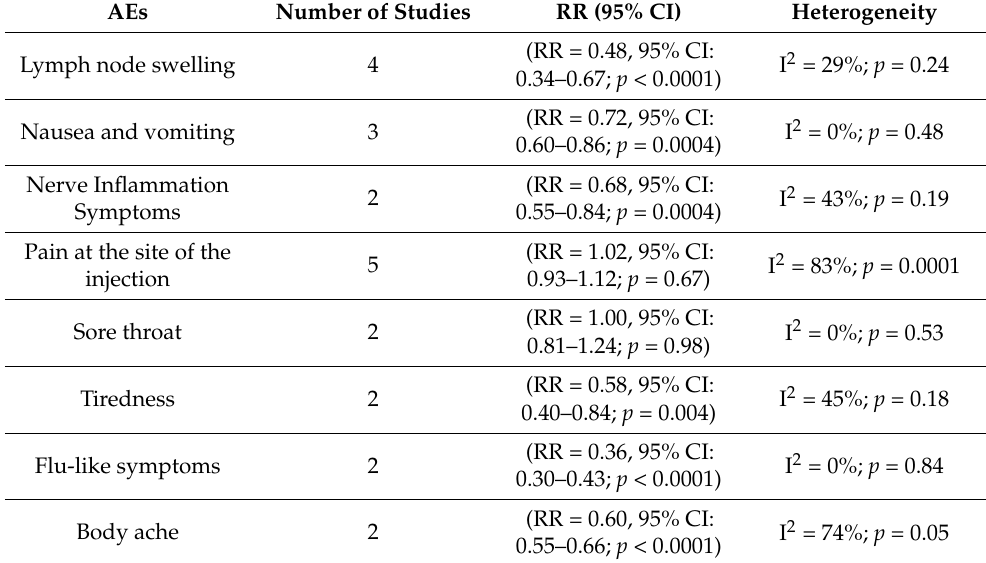
Table 4. Dose-dependent